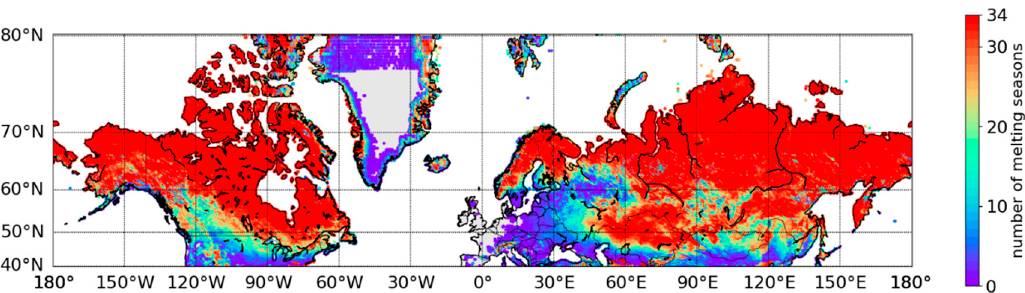
Figure 3. Number of successful retrievals of melt season per resolution unit during the 34 years.